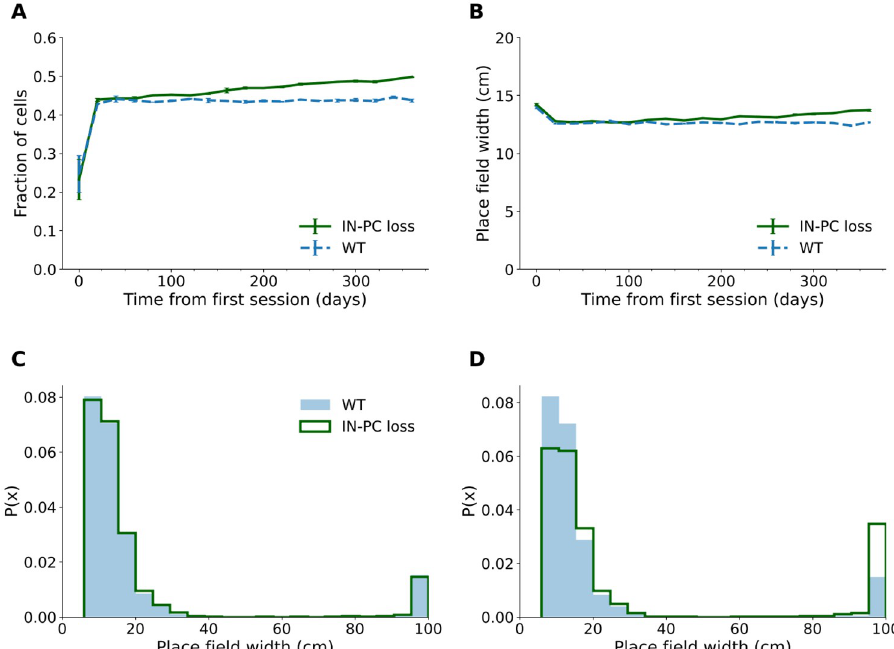
Fig 5. Place cell proportion and mean place field width increased over time when inhibitory synapses were lost. (A) Proportion of place cells over 365 days in the interneuron-to-pyramidal cell (IN-PC) synapse loss and wildtype (WT) model. (B) Mean place field width over 365 days, excluding widths > 50 cm. The means of 2 runs of the simulation are shown in (A) and (B), Error bars show pooled standard error of the mean. Representative probability density functions of place field widths on day 20 (C) and 360